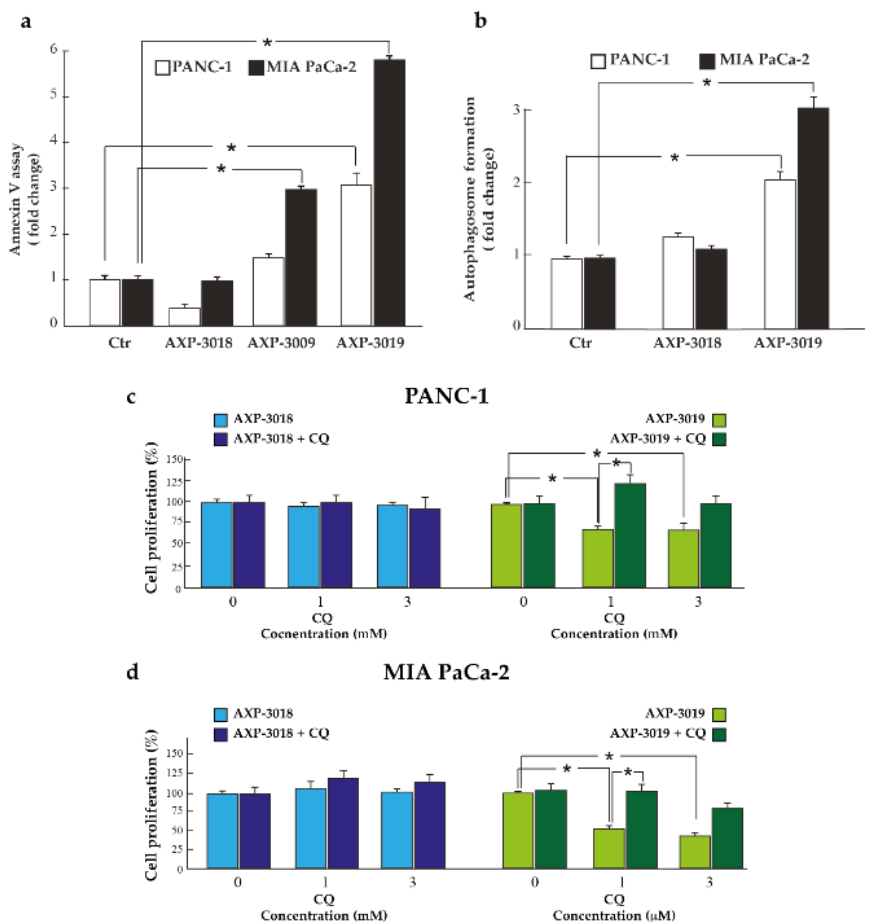
Figure 6. Apoptosis and autophagy events in PDAC cell lines. PDAC cell lines were seeded in 96-well plate and were treated with 10 µ M of 3-bromo-isoxazoline derivatives. After 48 h, cells were fixed and stained with annexin V/FITC probe in order to analyse apoptosis ( a ) and with the fluorescent probe monodansyl-cadaverine (MDC) to quantify autophagic vesicles formation ( b ). The values were normalized on cell proliferation by crystal violet assay. In ( c ) and ( d ), the percentage of cell growth after treatment with inhibitors with or without chloroquine (CQ) is shown. Statistical analysis * p < 0.05.